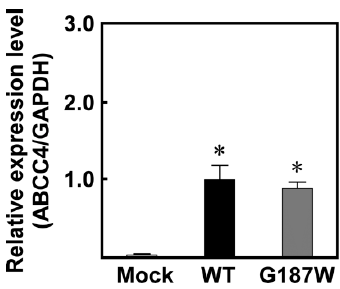
Figure 3. Levels of ABCC4 mRNA in cells established using the Flp-In™ system. The levels of ABCC4 and GAPDH mRNA were measured using qPCR with specific primer sets for ABCC4 and GAPDH , as described in Materials and Methods. Data are calculated as ratios relative to the GAPDH mRNA levels in the cells and normalized to the ratio of ABCC4 / GAPDH . Data are expressed as mean values ± S.D. (n = 5). Statistical analyses were performed using one-way ANOVA and Tukey’s HSD test (* p < 0.01 compared to the Mock